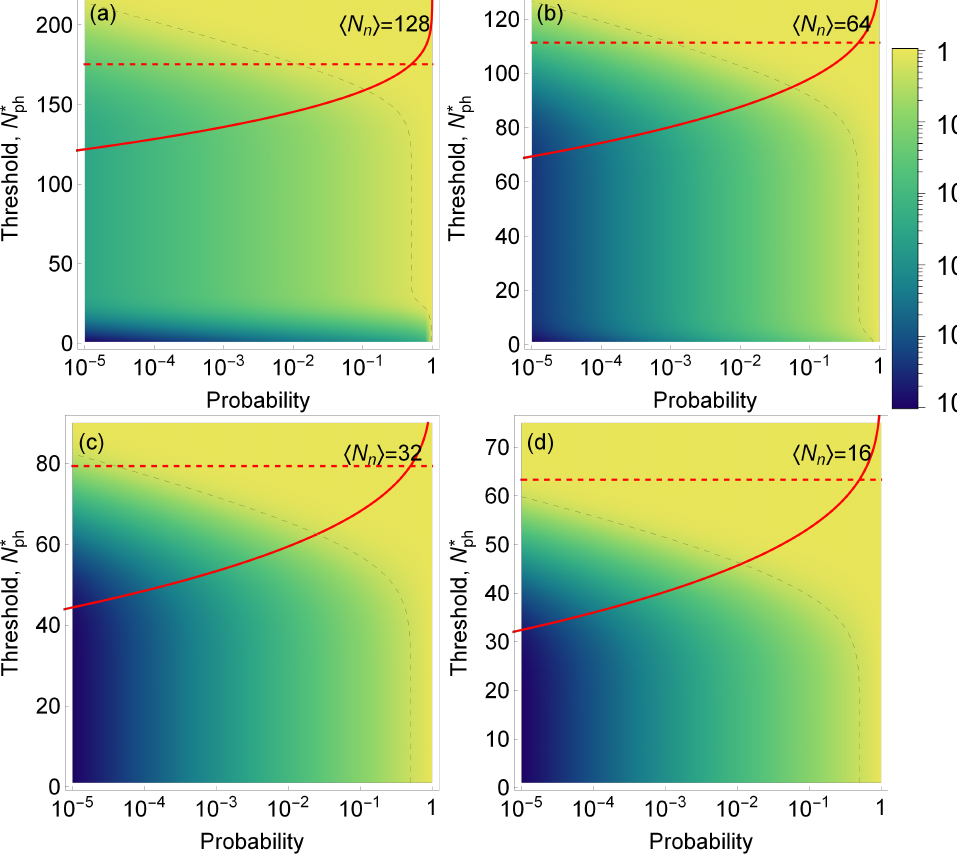
Figure 5. Color map of the success rate S (i.e., the fraction of time when the volume identified as that containing six emitters indeed contains six emitters as opposed to just two emitters) as a function of the probability of encountering a volume with six emitters in a sample (horizontal axis) and the threshold for number of photons detected (left vertical axis). Dashed gray line is the isoline for success rate of 50%. Red line: the probability F to erroneously discard trials containing six biomarkers ) = 50%. This as a function of the threshold level N ∗ ; dashed red line shows N ∗ for which F ( N ∗ ph ph ph example models the identification of overexpressed HER-2 gene with six copies in a cell versus normal two copies (six biomarkers versus two biomarkers). We assumed a fixed signal intensity per biomarker (cid:104) N b (cid:105) = 8 (photons per trial) and noise intensities (cid:104) N n (cid:105) = { 128,64,32,16 } in ( a – d ), respectively. Note that even though the density plot and red curves are shown on the same plot, the horizontal axes have different meanings for F and S